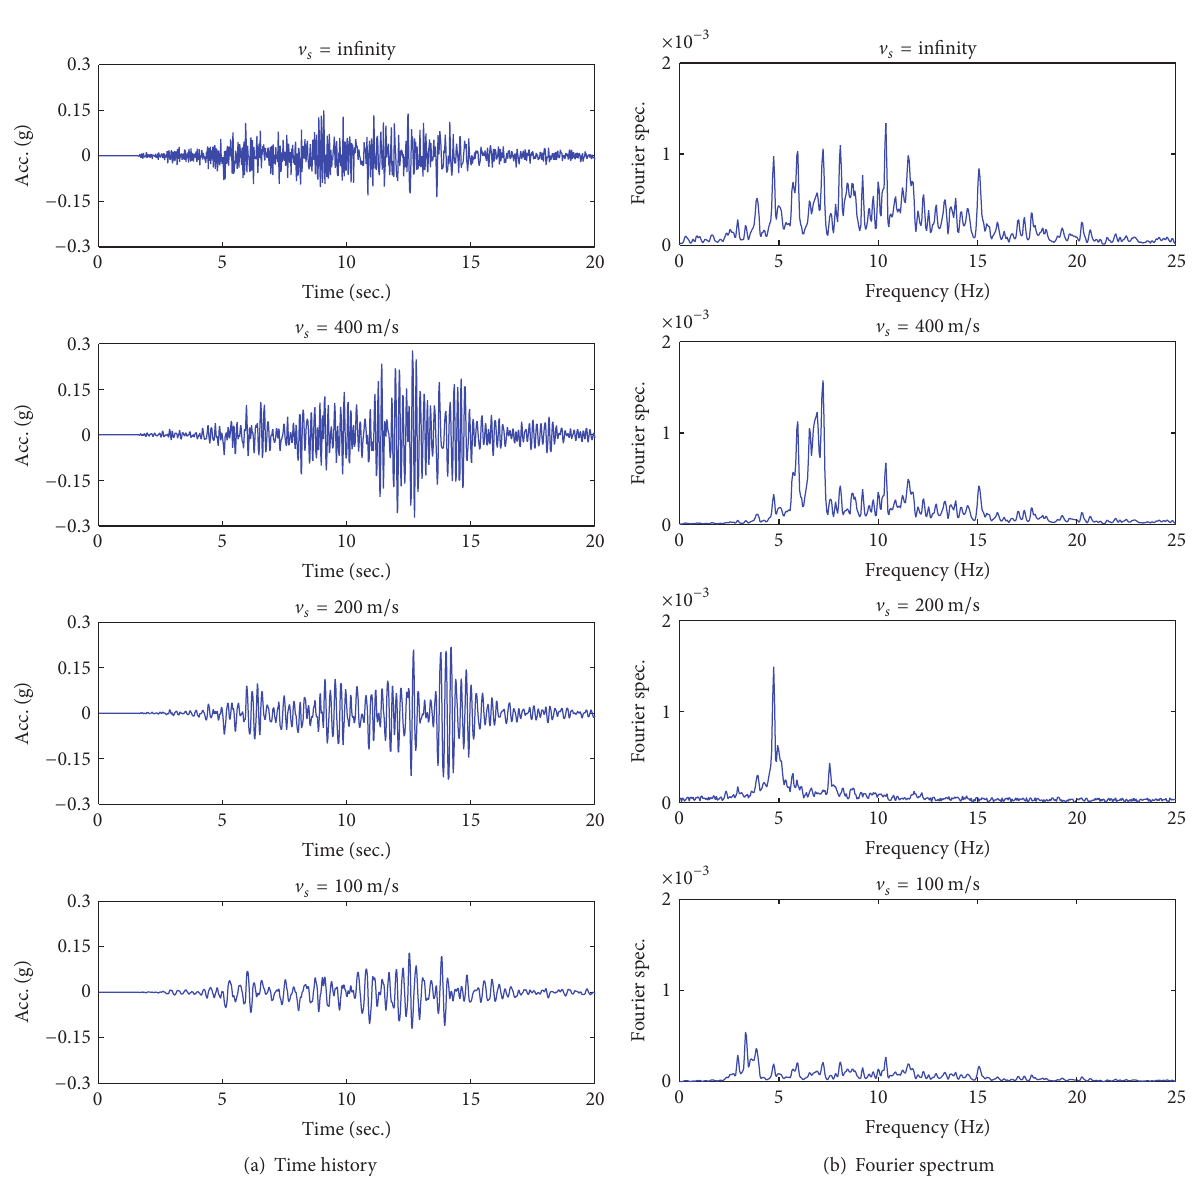
Figure 15: Acceleration response of the table below